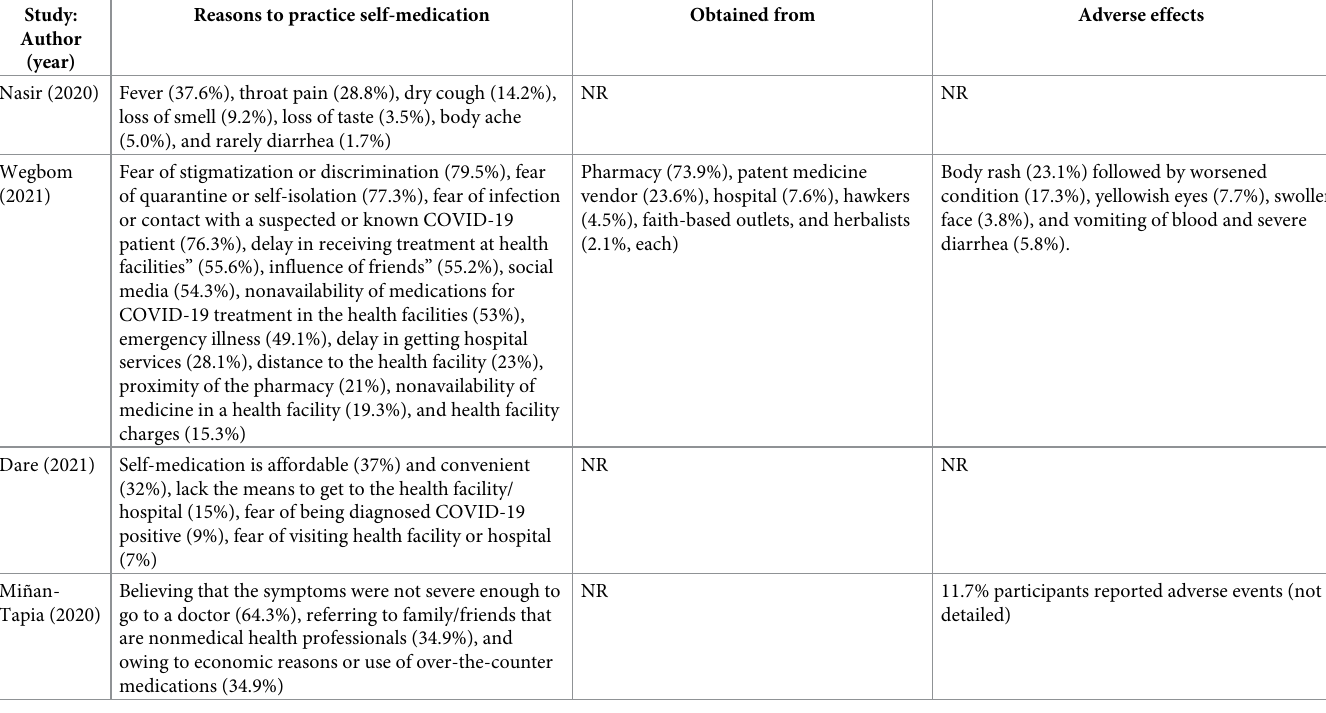
Table 3. Reasons to practice self-medication, from where were the medications obtained, and adverse